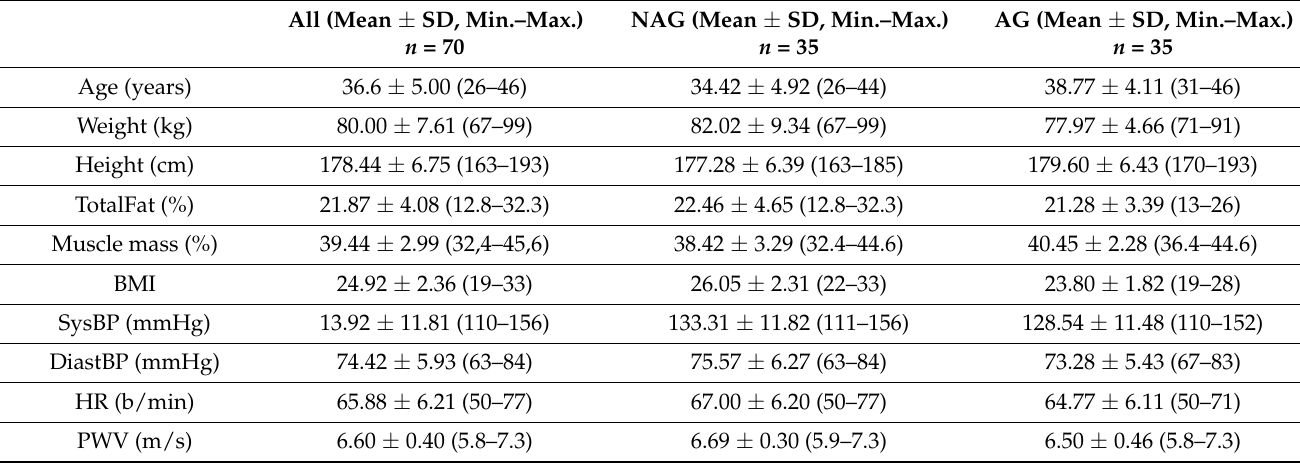
Table 1. Descriptive characteristics of patients enrolled in the study. All (Mean ± SD,